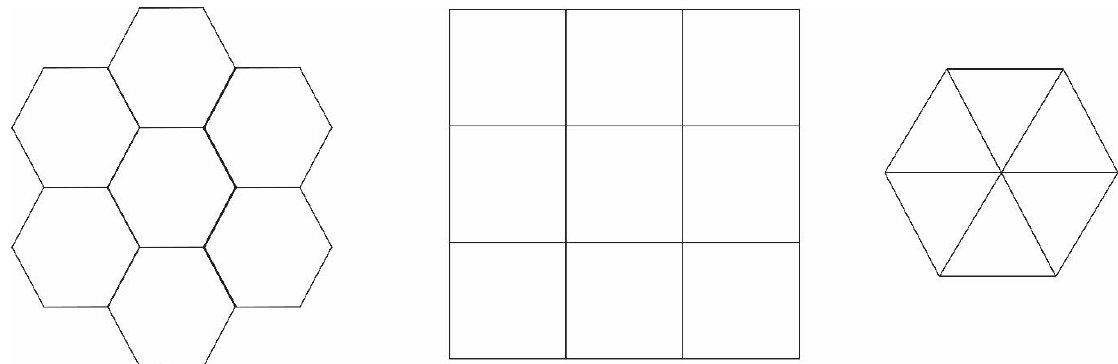
Figure 2. Schematic representation (top view) of the 2-D lattice templates studied here corresponding to extreme thin-film confinement (one layer between confining plates, n = 1). From left to right: honeycomb (coordination number of 3), square lattice (coordination number of 4) and triangular (coordination number of 6) lattices.